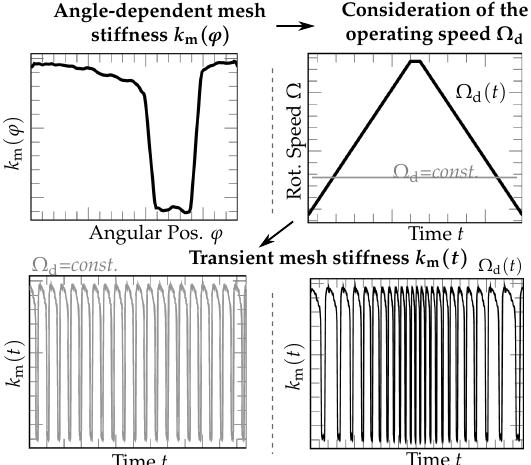
Figure 7. Schematic illustration of the conversion from angle-dependent mesh stiffness k m ( ϕ ) to time- dependent mesh stiffness k m ( t ) for constant (lower left) and varying operating speed (lower right).